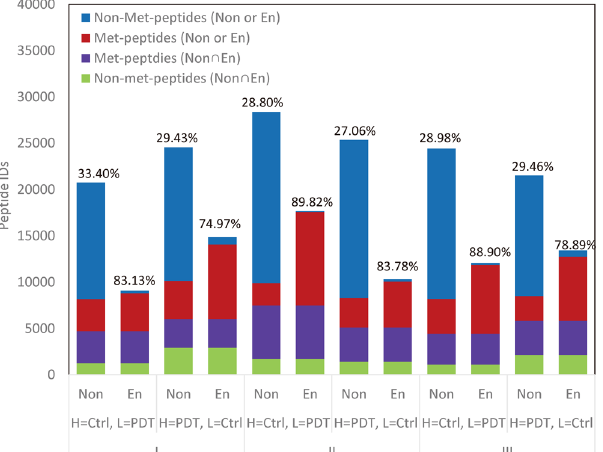
Figure 3. The efficiency of Met-peptide enrichment from A431 cells under the three different PDT conditions. The numbers of Met- and non-Met-peptides detected in the non-enriched and enriched samples were calculated for each condition. The three conditions (with swapping experiments) were analyzed separately. The red bars indicate the Met-peptides specifically identified in either non-enriched or enriched samples, while the purple bars indicate Met-peptides that were commonly identified in both, and the blue and green bars represent non-Met-peptides. The number above each column denotes the Met-peptides as a percentage of the total identified